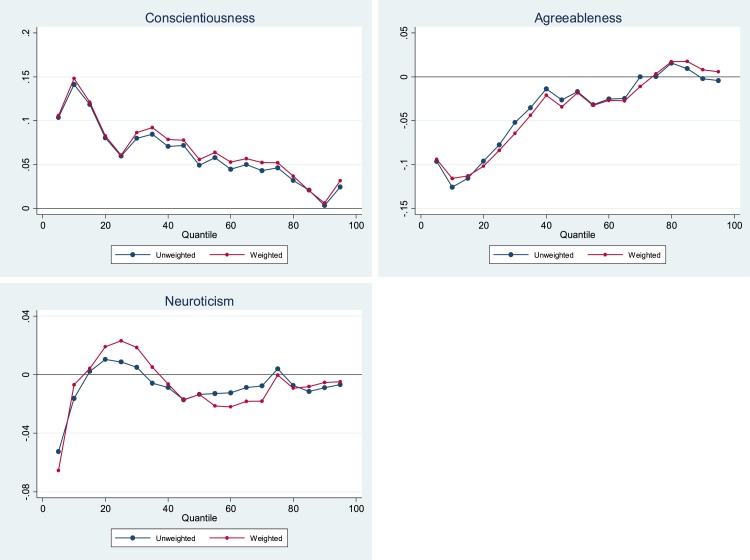
Weighted non-cognitive skills – cortisol t1-t2 relationship.